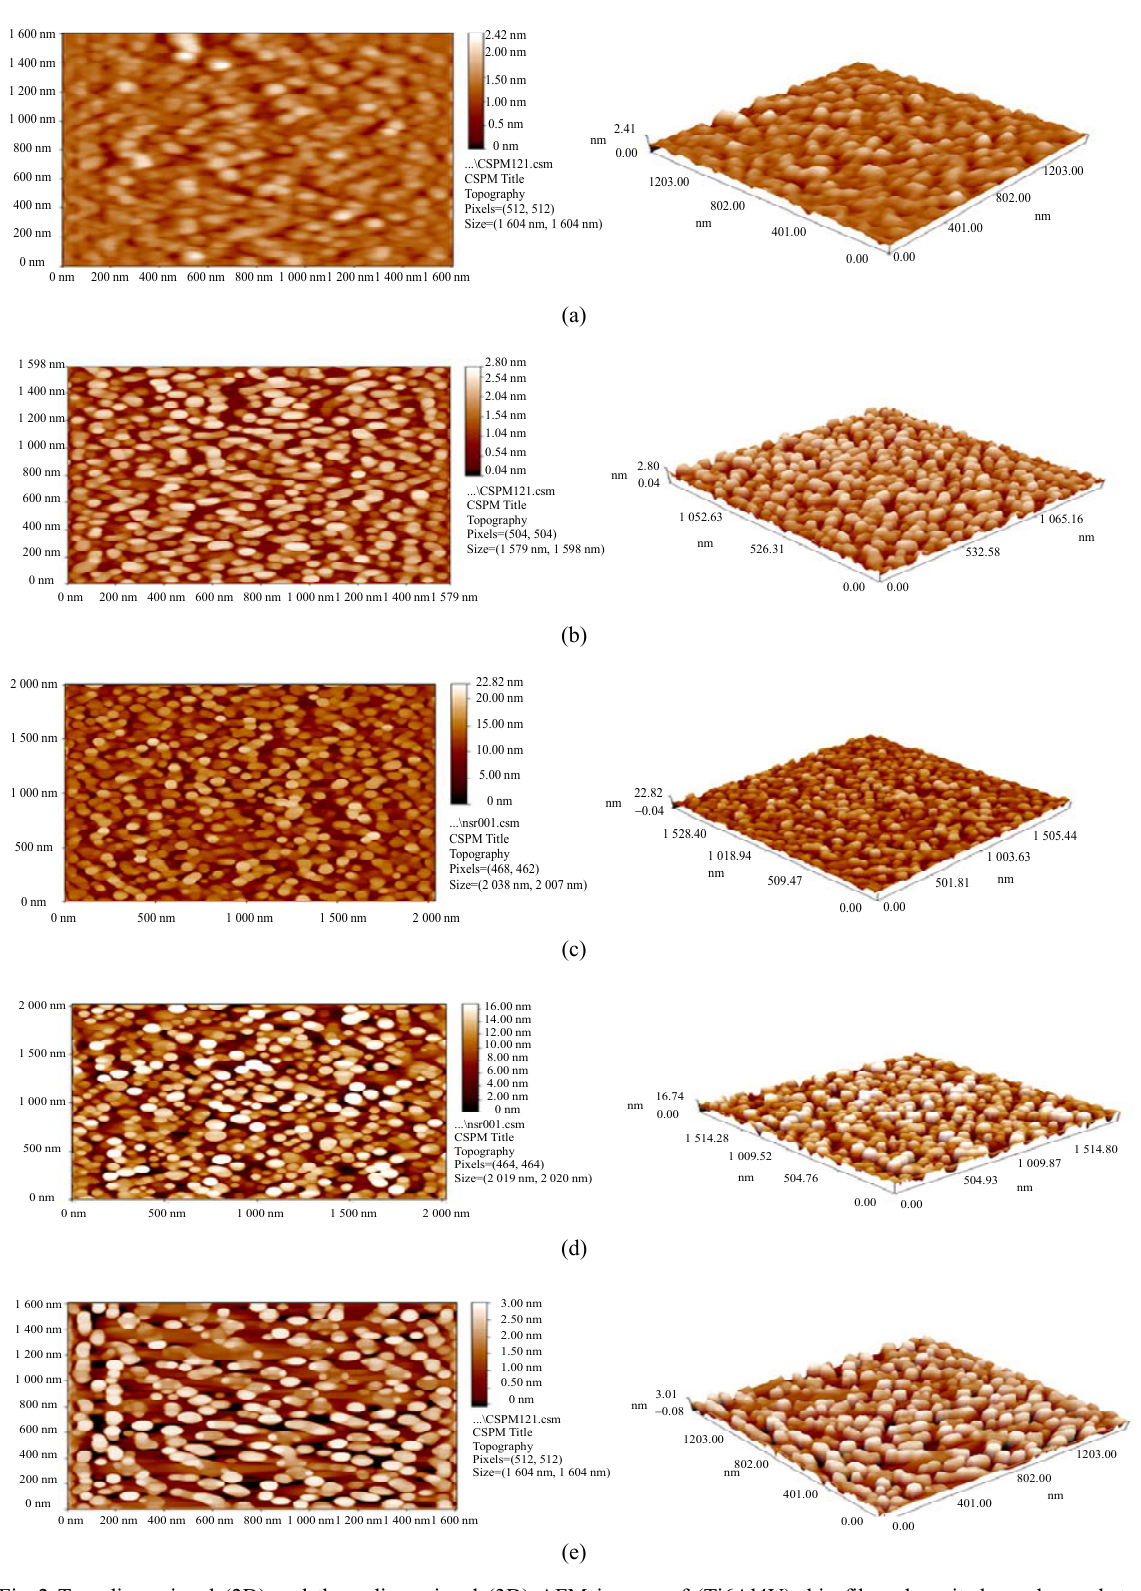
Fig. 2 Two-dimensional (2D) and three-dimensional (3D) AFM images of (Ti6Al4V) thin films deposited on glass substrate at different RF powers: (a) 50 W, (b) 75 W, (c) 100 W, (d) 125 W, and (e) 150